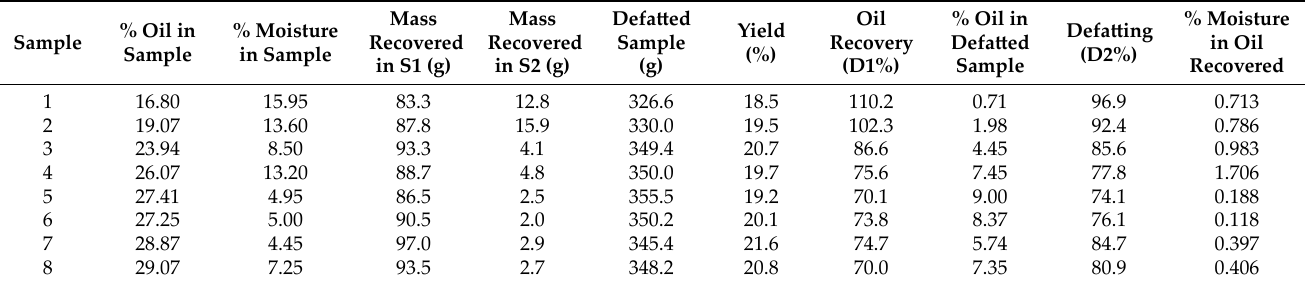
Table 2. Supercritical CO 2 defatting of different batches of H. illucens larvae at 450 bar, 60 larvae, 130 g/min CO 2 , and 190 min (1350 cm 3